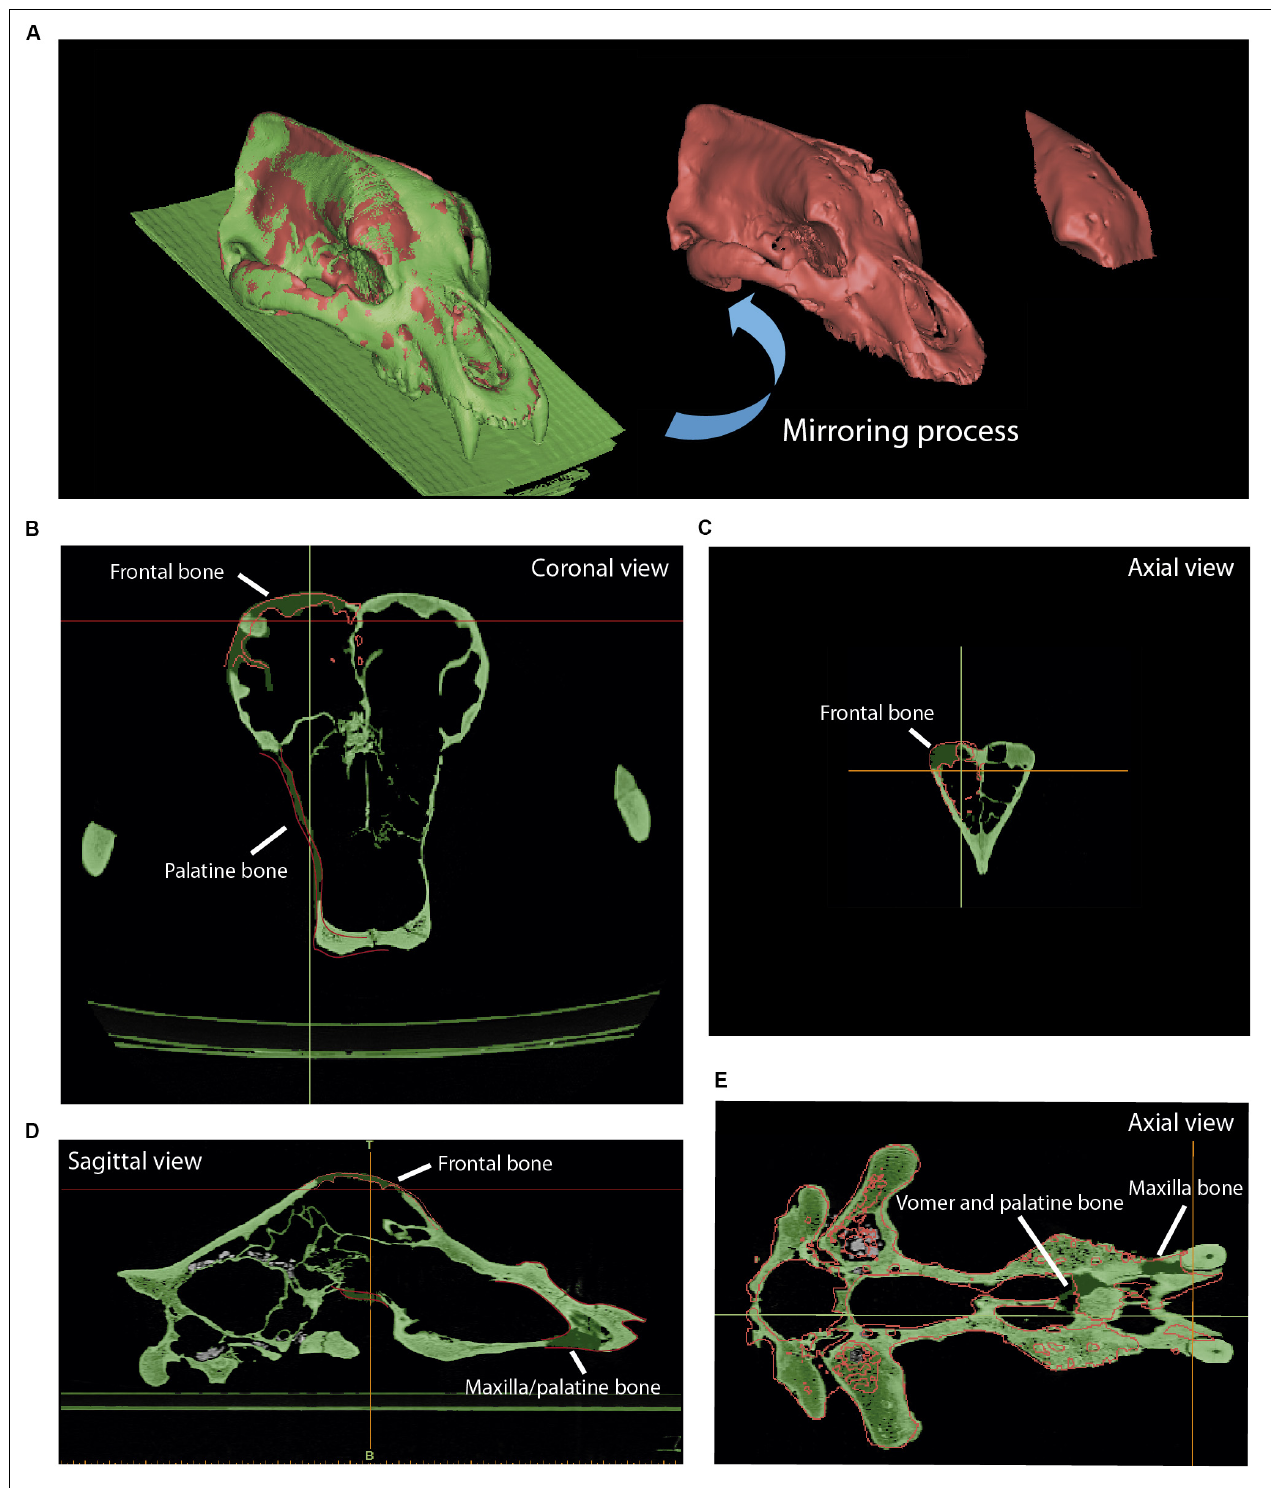
FIGURE 7 | Reconstruction of the skull of Ursus spelaeus eremus (PIUW-SW 483). (A) Three-dimensional models showing in red the mirrored parts of the frontal dome and in green the original bone. (B) Coronal view showing the red polyline to reconstruct the lacking parts of bone. (C) Axial view showing the red polyline to reconstruct the left portion of the frontal bone. (D) Sagittal view showing the reconstructed parts of the frontal, maxillary, and palatine bones. (E) Axial view showing the reconstructed bone parts of the vomer, palatine, and maxillary bones.